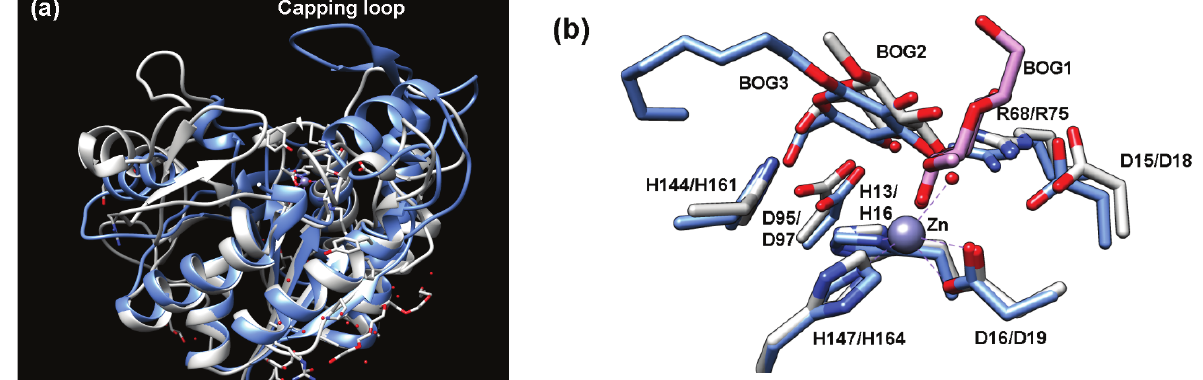
Figure 6. ( a ) Overlay of teicoplanin deacetylase (blue, PDB 2XAD) and MshB (gray, PDB 4EWL) highlights the additional capping loop present in teicoplanin deacetylase; ( b ) Overlay of teicoplanin deacetylase (blue, PDB 2X9L) and MshB (gray, PDB 1Q7T) containing bound BOG molecules. The numbering corresponds to MshB/teicoplanin deacetylase. In this rendering, both MshB monomers are overlaid (BOG1 and BOG2) with teicoplanin deacetylase